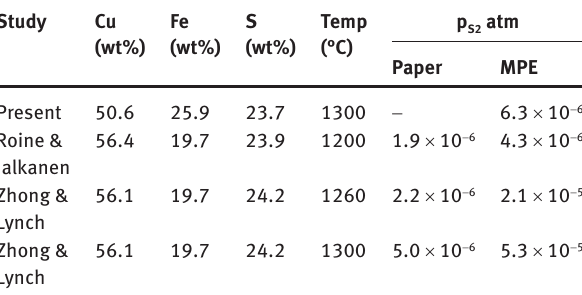
Table 7: Comparison of sulphur partial pressures of this study and previous studies [6, 8] calculated from the matte composition by the MPE